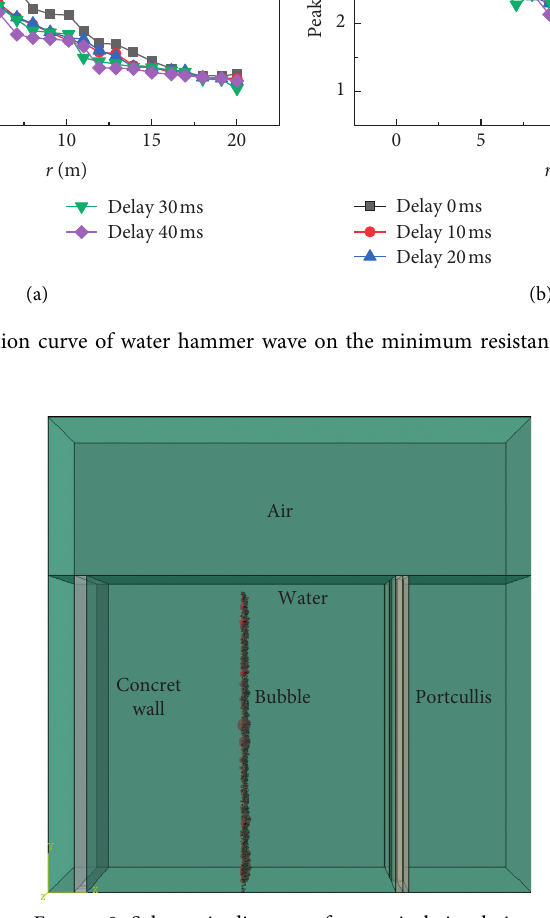
Figure 9: Schematic diagram of numerical simulation.